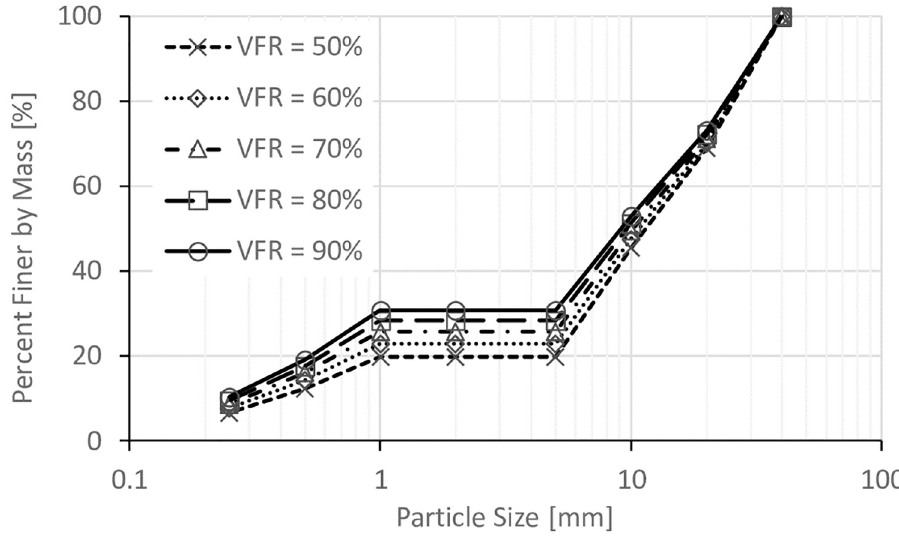
Fig 3. Particle size distributions for samples with D c =